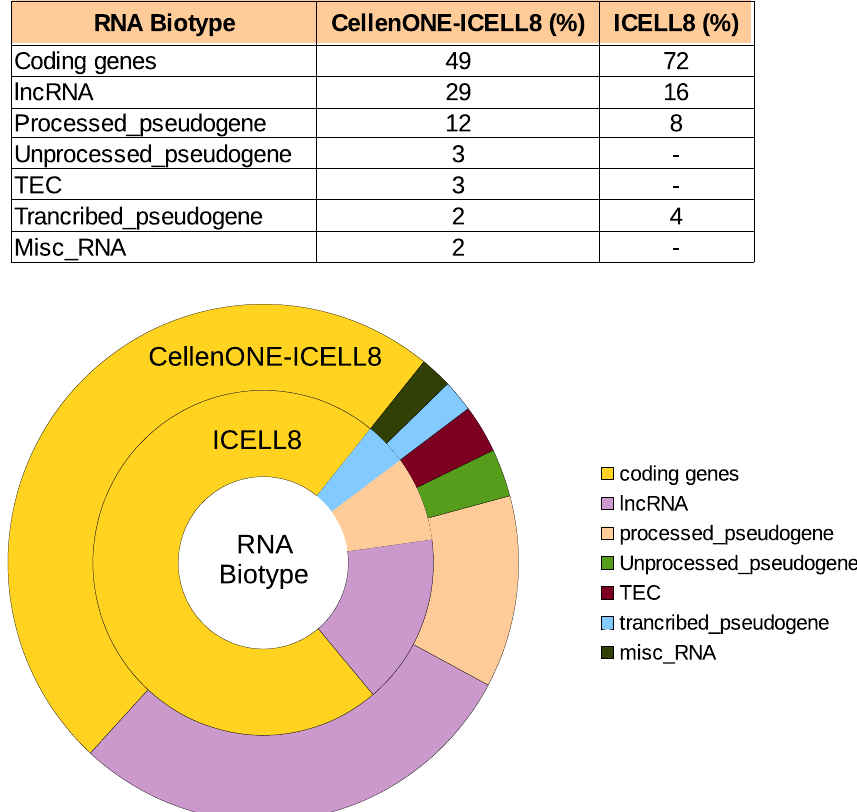
Table 3. RNA-Biotype percentages identified in sample GOE1309 using the CellenONE-ICELL8 and ICELL8